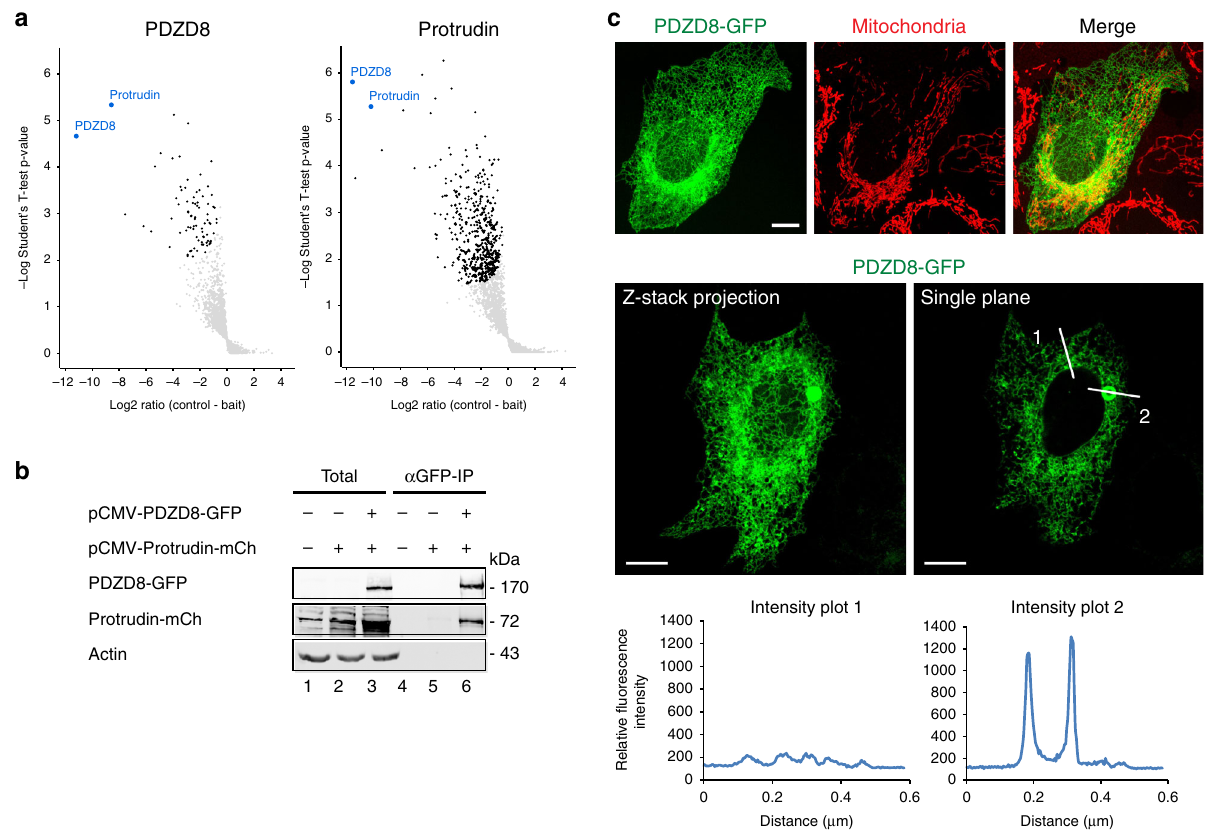
Fig. 1 PDZD8 interacts with Protrudin and is enriched in ER subdomains. a Endogenous PDZD8 and Protrudin interact. Volcano plots of mass- spectrometry based results from an analysis of immunoprecipitates using anti-PDZD8 (left panel) and anti-Protrudin (right panel) antibodies from crosslinked human HCT116 cell lysates showing signi fi cant potential interactors (in black), identi fi ed using one-sided Student ’ s t test (FDR 0.05, S0 = 0.1). PDZD8 and Protrudin are labeled in blue. Volcano plots represent experiments performed in three biological replicates for each condition. Source data are provided as a Source Data fi le. b Analysis of the PDZD8-GFP and Protrudin-mCherry interaction by immunoprecipitation from cell extracts. Extracts from HEK293T cells expressing Protrudin-mCherry, both Protrudin-mCherry and PDZD8-GFP or with no vector were immunoprecipitated with anti-GFP-Trap beads and western blot analysis was performed using anti-GFP, anti-Actin, and anti-Protrudin antibodies for detection of PDZD8-GFP, Actin, and Protrudin- mCherry (designated Protrudin-mCh), respectively. Source data are provided as a Source Data fi le. c PDZD8-GFP localizes to ER and to ER subdomains in cells. Top panel: representative images of U2OS cells expressing PDZD8-GFP (z-stack projection). Pdzd8-GFP (in green) and mitochondria (in red) labeled with MitoTracker DeepRed. Scale bar: 10 μ m. Middle panel: U2OS cell expressing PDZD8-GFP (in green) shown full Z-stack projection (left) and a single plane (right). Lower panel: plots of pixel intensity versus distance using ImageJ software corresponding to the lines marked 1 and 2 on the single plane image in the middle